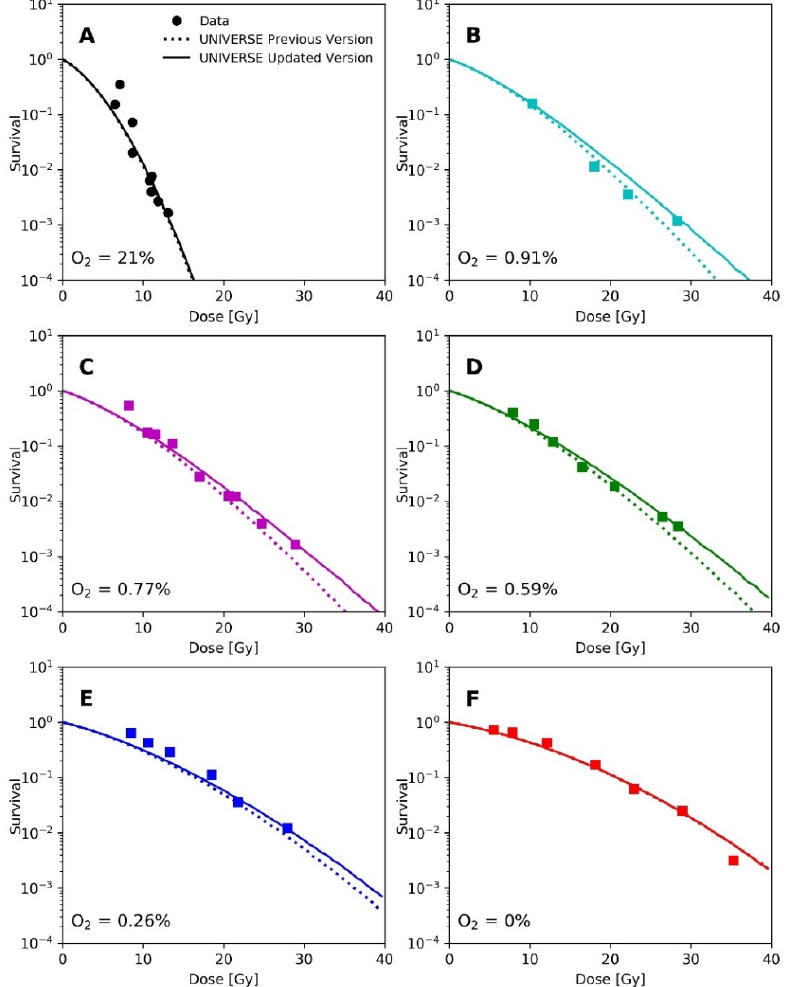
Figure 4. Panels ( A – F ): Measured survival (filled circles and squares) of HeLa cells after irradiation with a 3 ns electron pulse under different environmental oxygen levels taken from Epp et al. [20] and respective predictions by previous version of UNIVERSE (dotted lines) and the updated UNIVERSE including the extensions presented in this study (solid